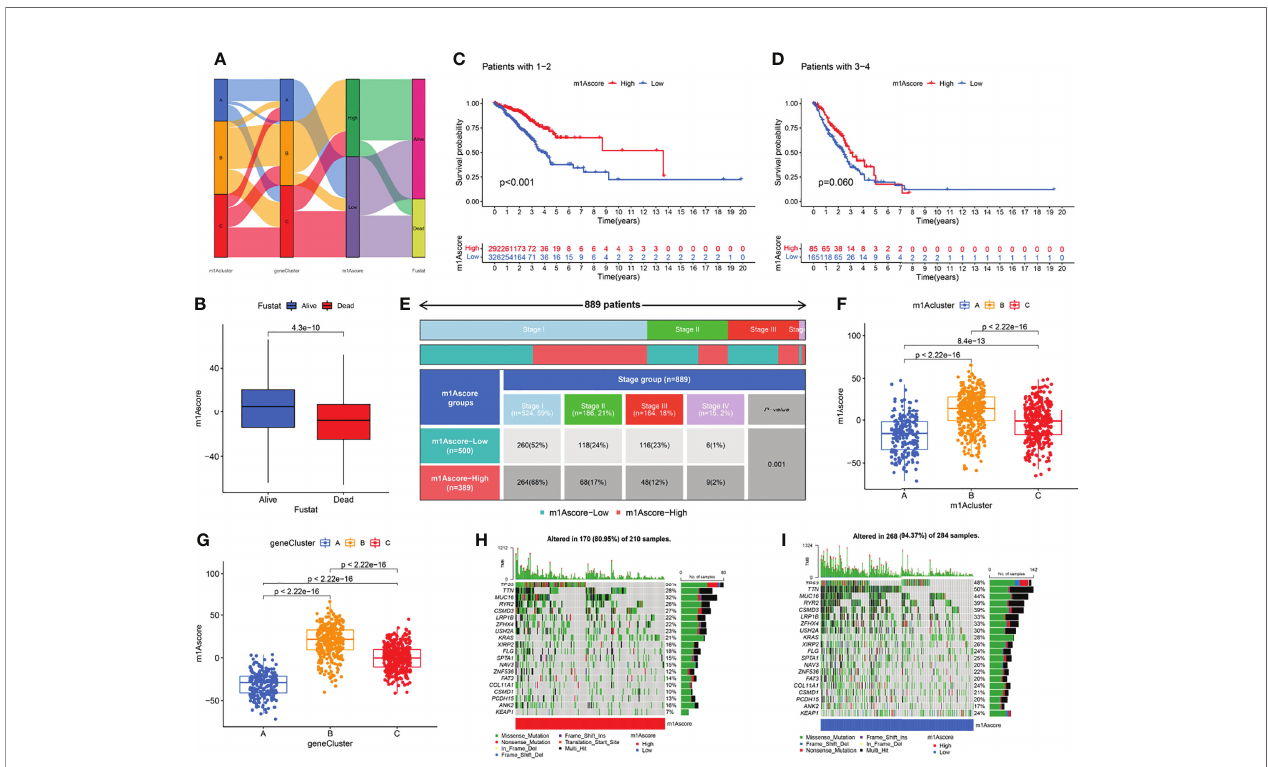
FIGURE 5 | Clinical features in different m1A score groups. (A) Alluvial plots depicted the correspondence in m1A clusters, m1A gene clusters, m1A score, and the survival status of patients in LUAD. (B) The differences of fustat in different m1A score groups. (C – E) Kaplan-Meier curves uncovered differences in m1A scores among LUAD patients at different pathological stages. (F, G) The differences of m1A score among three m1A modi fi cation patterns and three m1A gen clusters. (H, I) The differences of somatic mutation frequency in tumor genomes based on the grouping of m1A